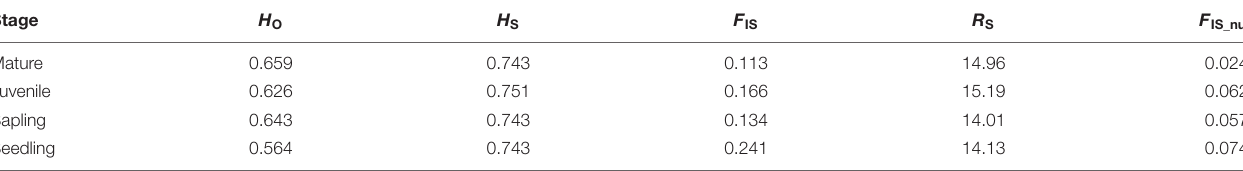
TABLE 1 | Genetic diversity of each growth stage of Picea jezoensis .